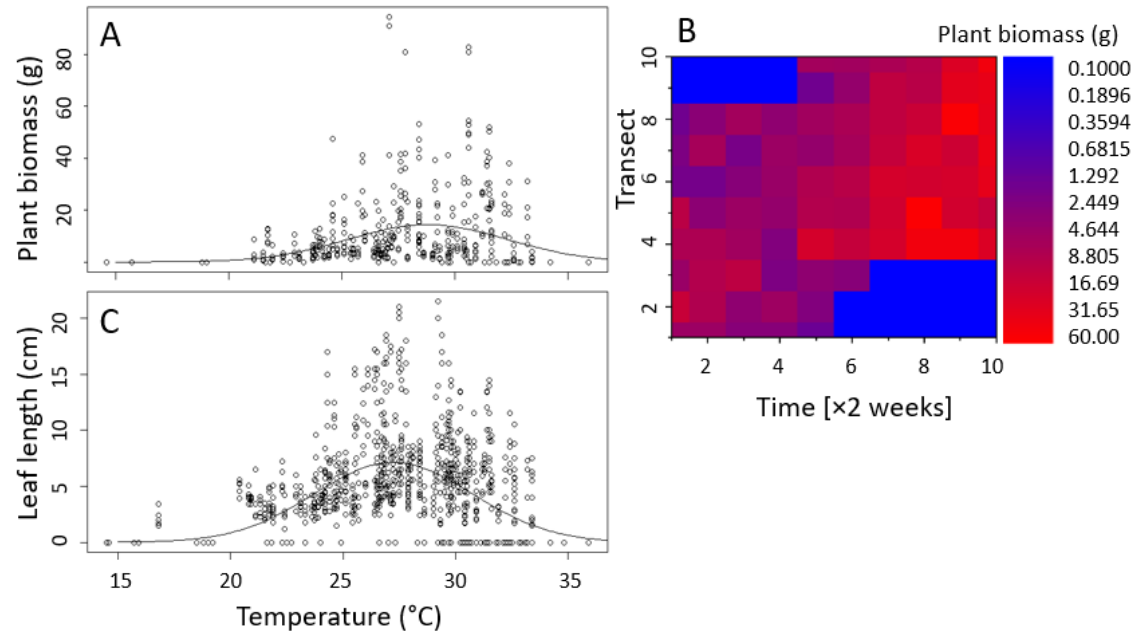
Figure 5. Effect of water temperature on fresh Pistia stratiotes biomass ( A , B ) and leaf length ( C ).